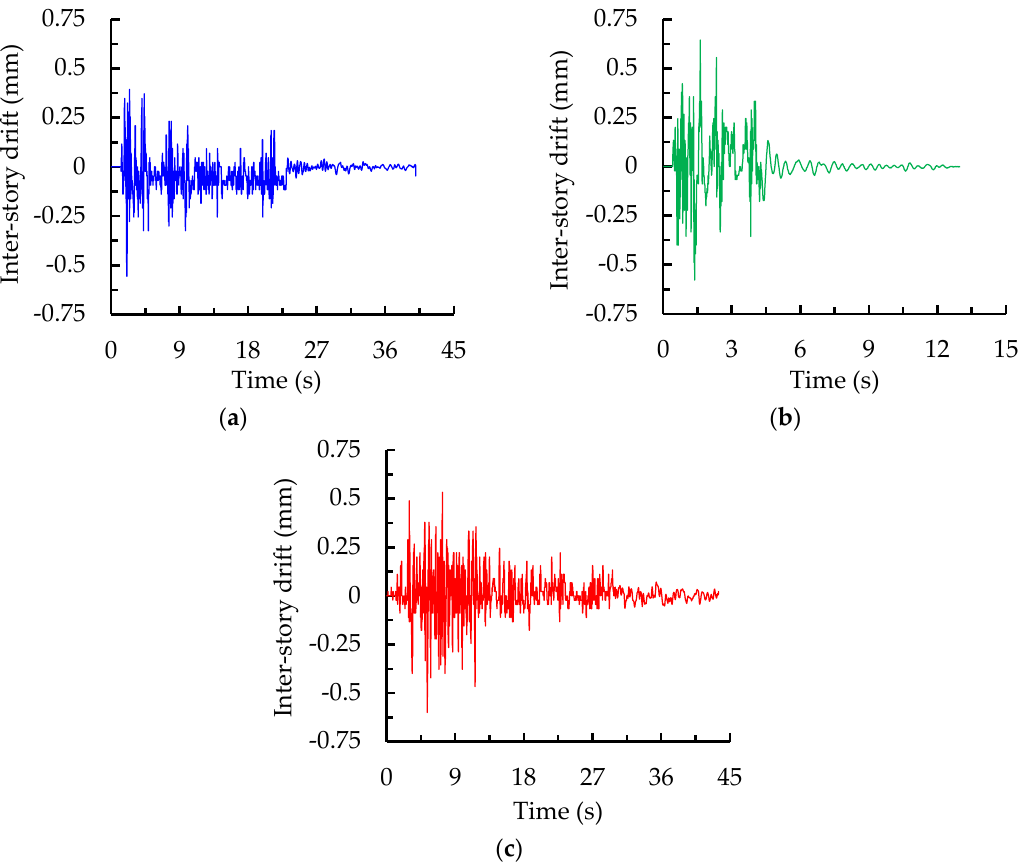
Figure 19. Inter-story drifts at the bottom floor under PGA of 0.5 g for three seismic waves. ( a ) El Centro wave; ( b ) Kobe wave; ( c ) Taft wave.